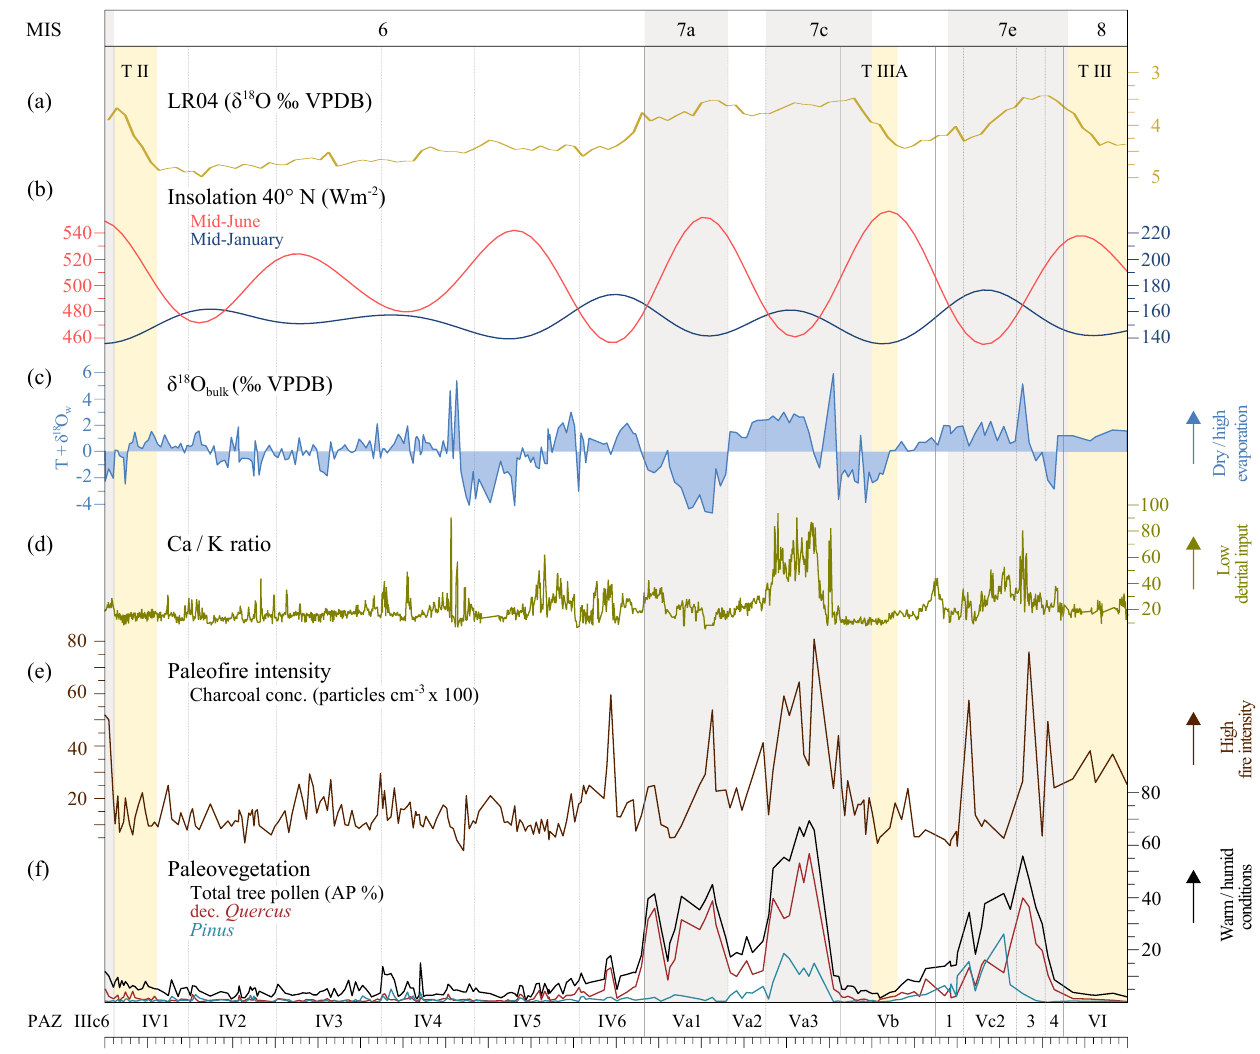
Figure 3. Comparative study of Lake Van paleoenvironmental proxies during the penultimate interglacial–glacial cycle. (a) LR04 isotopic record (in ‰ VPDB) with marine isotope stage (MIS) boundaries (gray bars) following Lisiecki and Raymo (2004). (b) Insolation values (40 ◦ N, Wm − 2 ) after Berger (1978) and Berger et al. (2007). (c) Lake Van oxygen isotope record δ 18 O bulk (‰ VPDB; newly analyzed isotope data including the already published isotope record by Kwiecien et al., 2014). (d) Calcium/potassium ratio (Ca / K) after Kwiecien et al. (2014). (e) Fire intensity at Lake Van (>20µm; charcoal concentration in particlescm − 3 ). (f) Selected tree percentages (total arboreal pollen (AP), deciduous Quercus , and Pinus ) including the pollen data from Litt et al. (2014); PAZ is pollen assemblage zone. Termination III at 250ka, TIIIA at 223ka, and TII at 136ka are indicated after Barker et al. (2011) and Stockhecke et al.